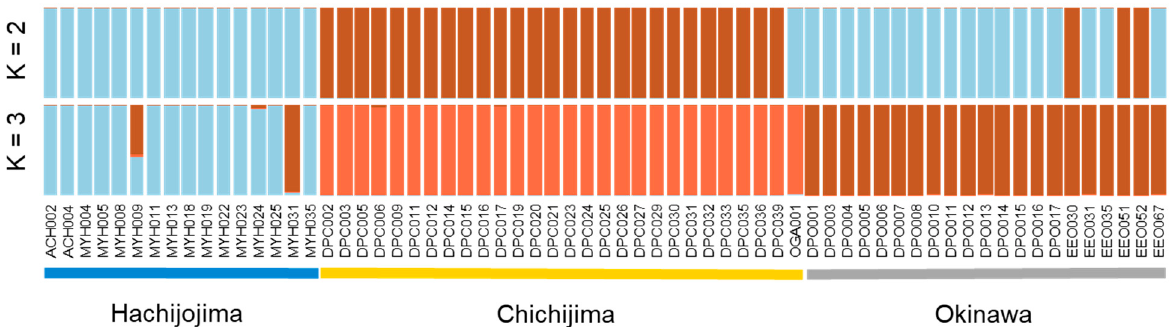
Figure 5. Compoplot from DAPC (discriminant analysis of principal components) for T . brunneus sampled from three island populations, for K = 2 (inferred most likely value) and K = 3.